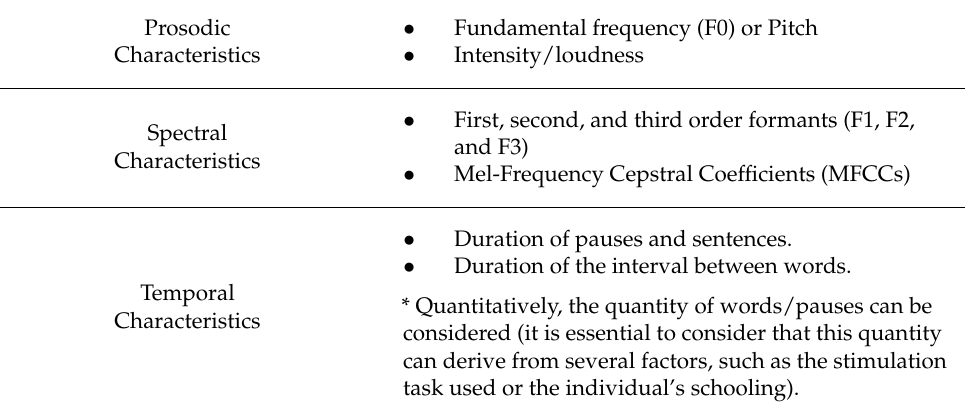
Table 3. Features with more influence on the identification of schizophrenia via